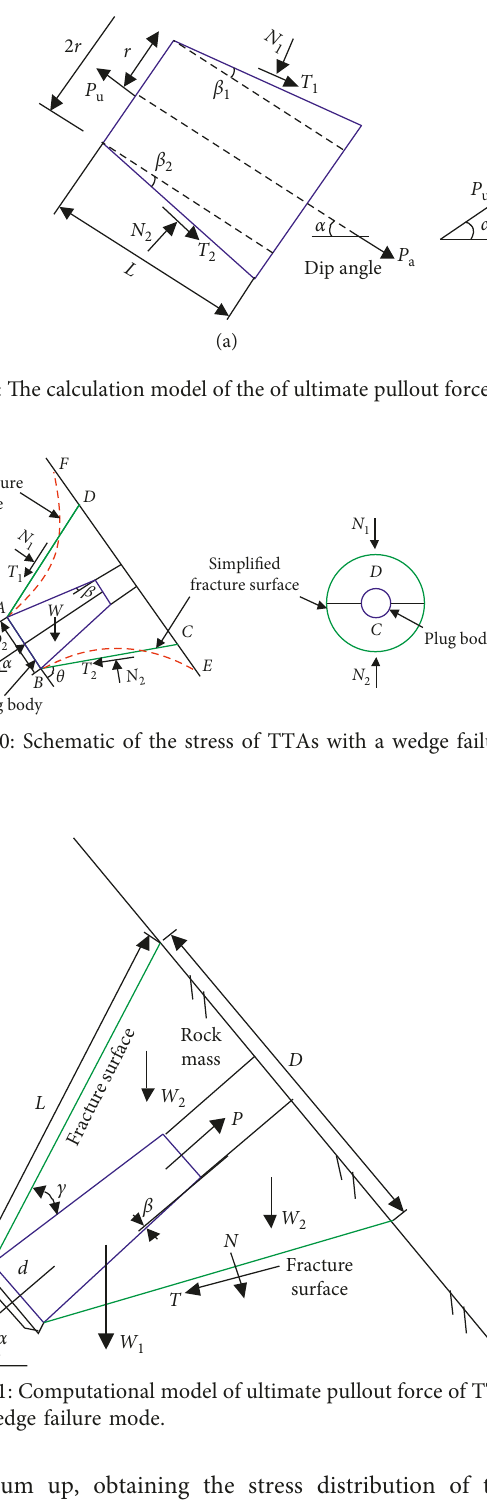
Figure 11: Computational model of ultimate pullout force of TTA with a wedge failure